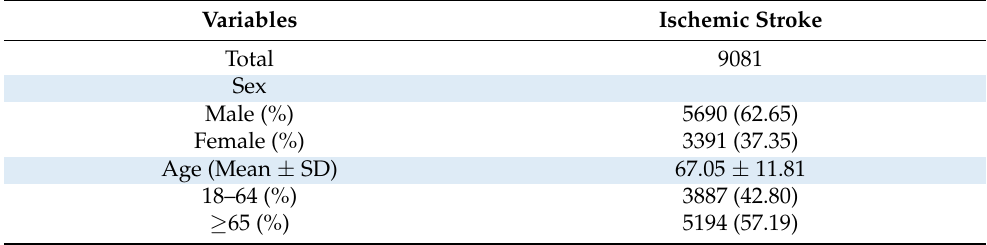
Table 1. Demographic Characteristics of hospitalizations for ischemic stroke in Tianjin